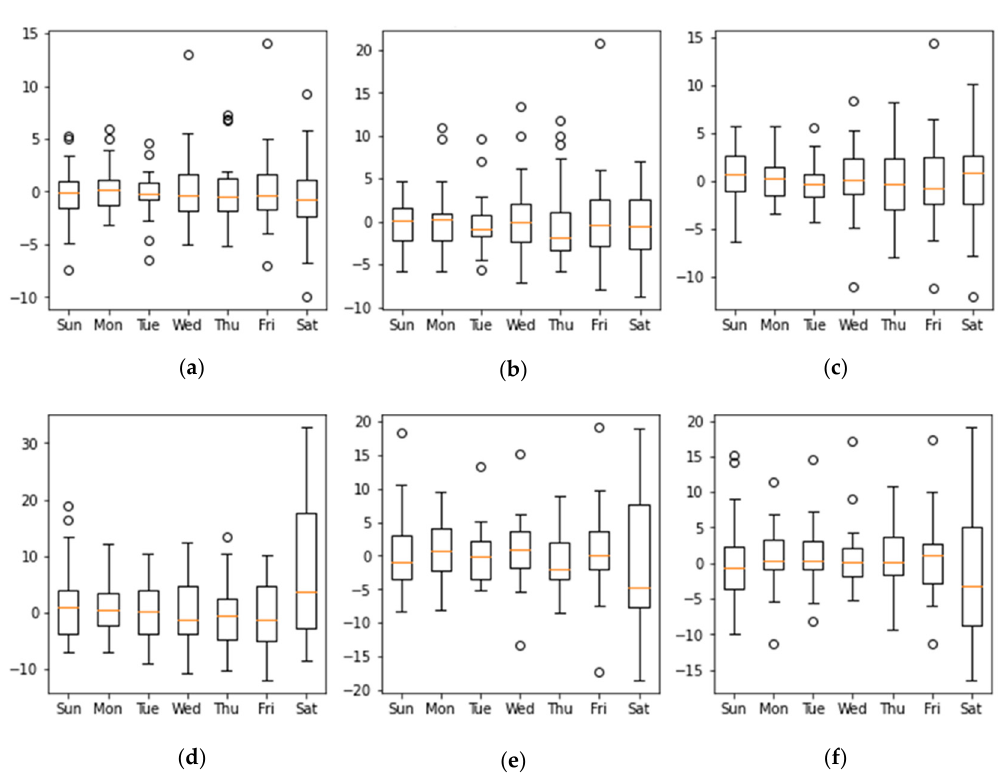
Figure 6. Comparison between the real speed and the predicted speed in boxplots: ( a ) one-step-ahead prediction error in northbound; ( b ) two-step-ahead prediction error in northbound; ( c ) three-step-ahead prediction error in northbound; ( d ) one-step-ahead prediction error in southbound; ( e ) two-step-ahead prediction error in southbound; ( f ) three-step-ahead prediction error in southbound.